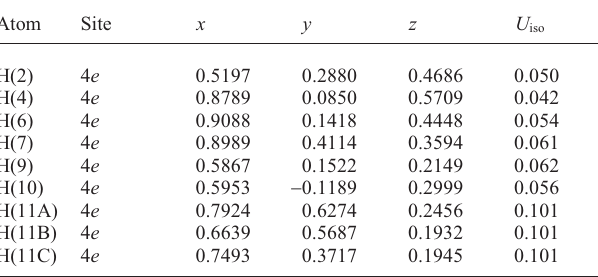
Table 2. Atomic coordinates and displacement parameters (in Å 2 )